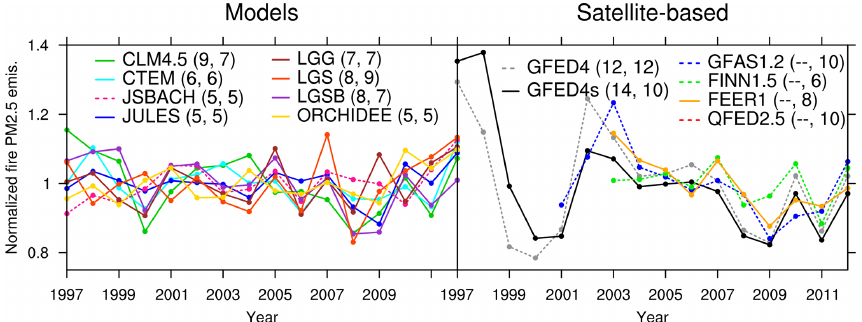
Figure 5. Temporal change in annual global fire PM 2 . 5 emissions normalized by the mean from FireMIP models and satellite-based products. The numbers in parentheses are coefficients of variation (CVs, the standard deviation divided by the mean, unit: %) for 1997–2012 and 2003– 2012,